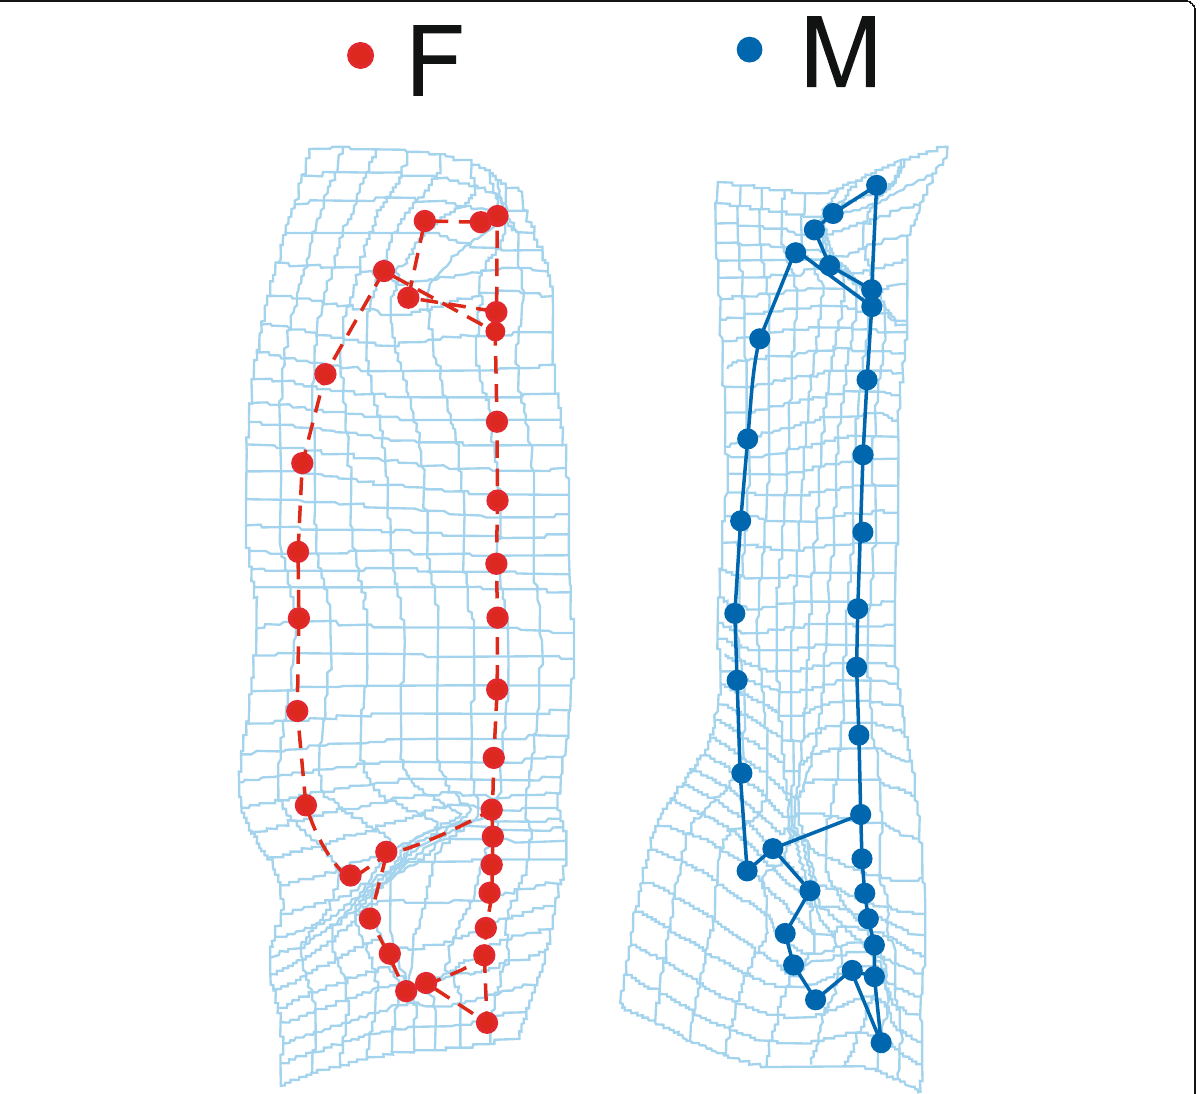
Fig. 6 Wireframe drawing of sexual dimorphism in body shape of isopod P. pruinosus . Deformation-based on discrimination functional analysis between two sexes. The graph visualizes how the average body shape of female differs concerning that of male. F, female; M,